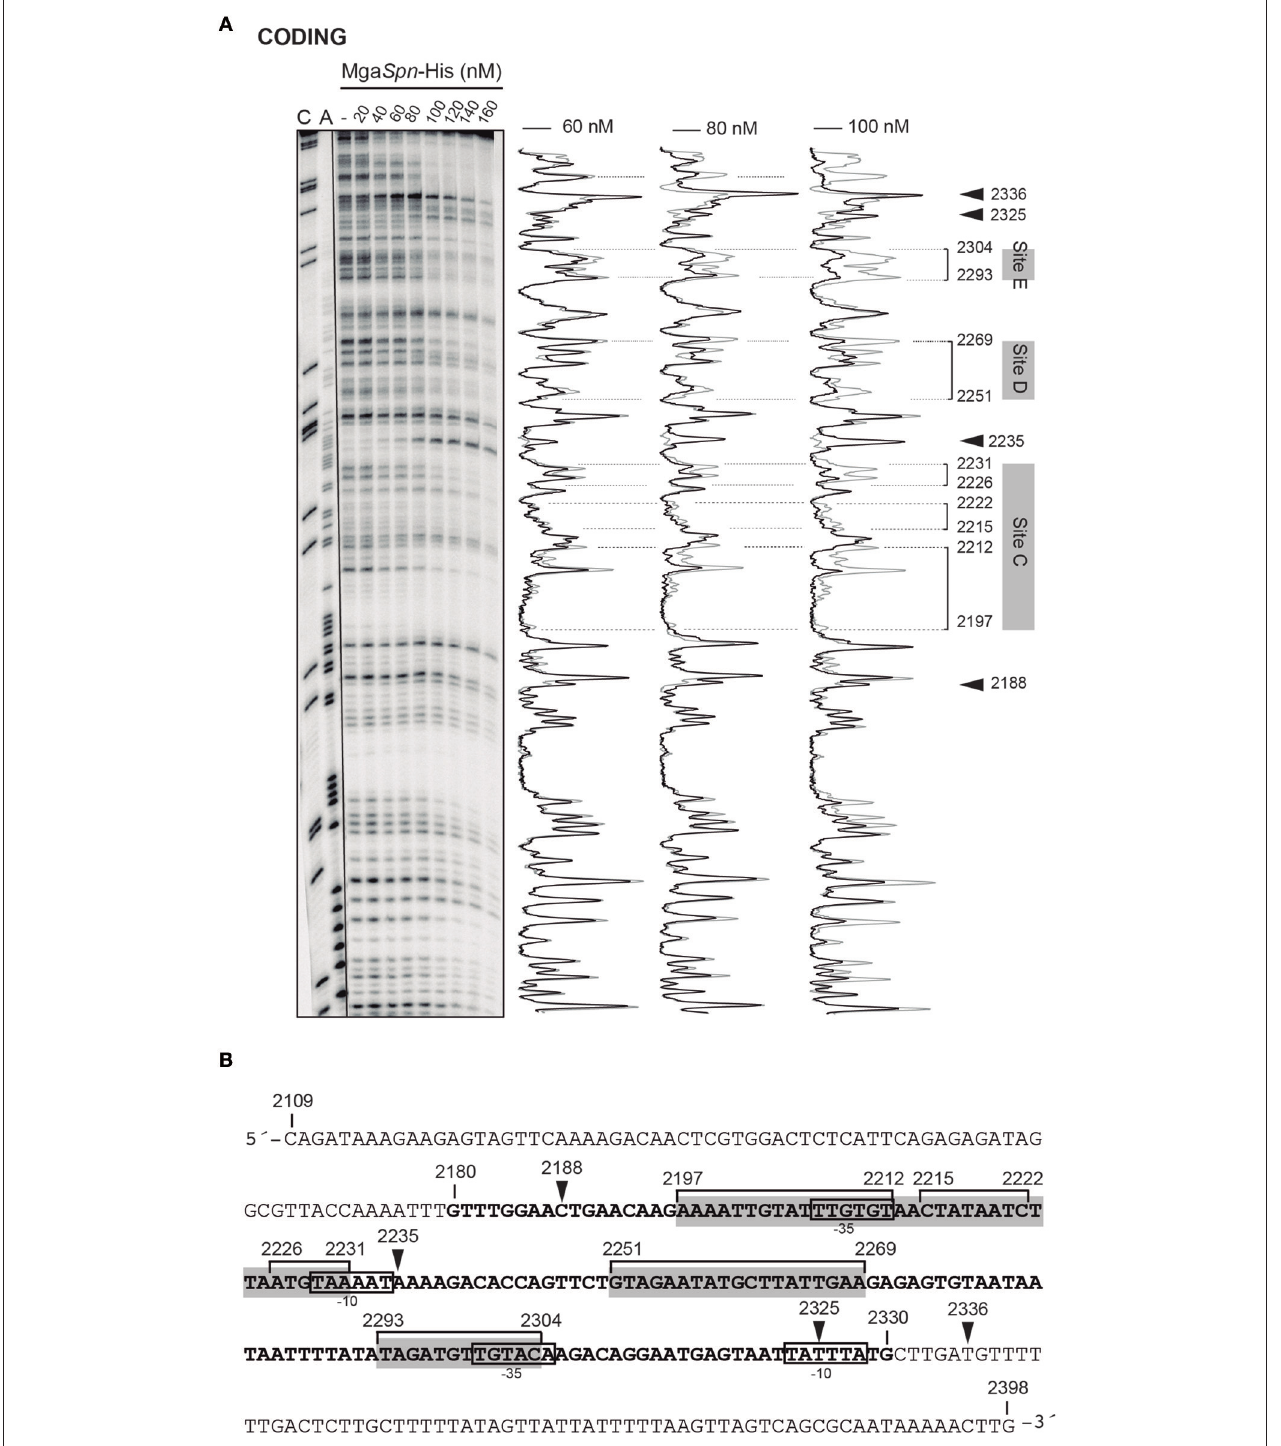
FIGURE 5 | DNase I footprints of complexes formed by Mga Spn -His on the 290-bp hlyC DNA fragment. (A) The hlyC DNA fragment (coordinates 2109–2398) was radioactively labeled at the 5 ′ -end of the coding strand. Labeled DNA (2nM) was incubated with the indicated concentrations of Mga Spn -His and then digested with DNase I. Dideoxy-mediated chain-termination sequencing reactions were run in the same gel (lanes A, C). Densitometer scans corresponding to free DNA (gray line) and DNA with protein (black line; 60, 80, and 100nM) are shown. The three primary sites (site C, site D and site E) recognized by Mga Spn -His on